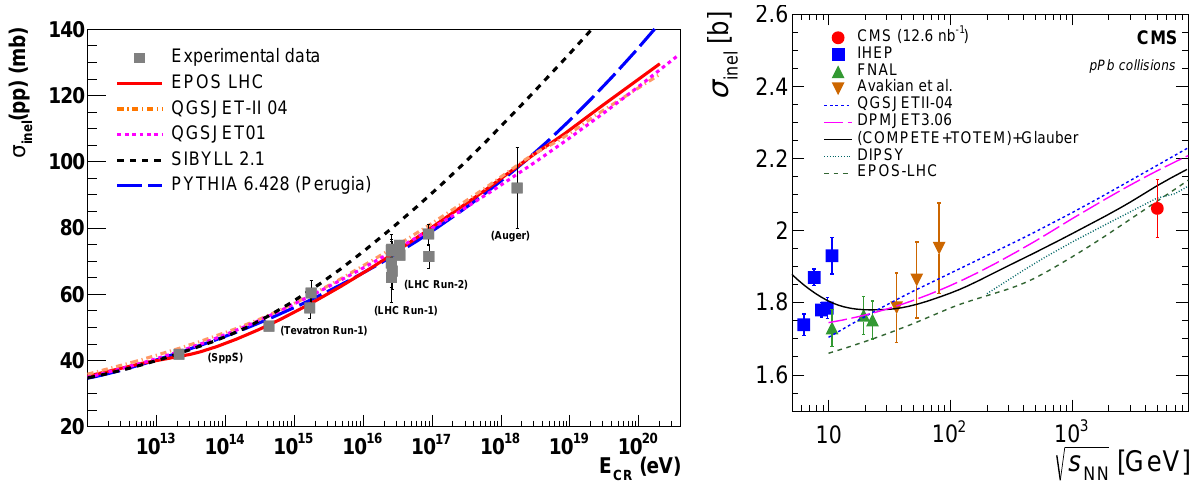
Figure 1. Left: Inelastic p-p cross section as a function of CR energy: Data compiled in [16, 39] compared to MC predictions retuned (except for sibyll ) to LHC Run-1 results [31]. Right: Inelastic p-Pb hadronic cross section (data and MC predictions) as a function of nucleon-nucleon collision energy